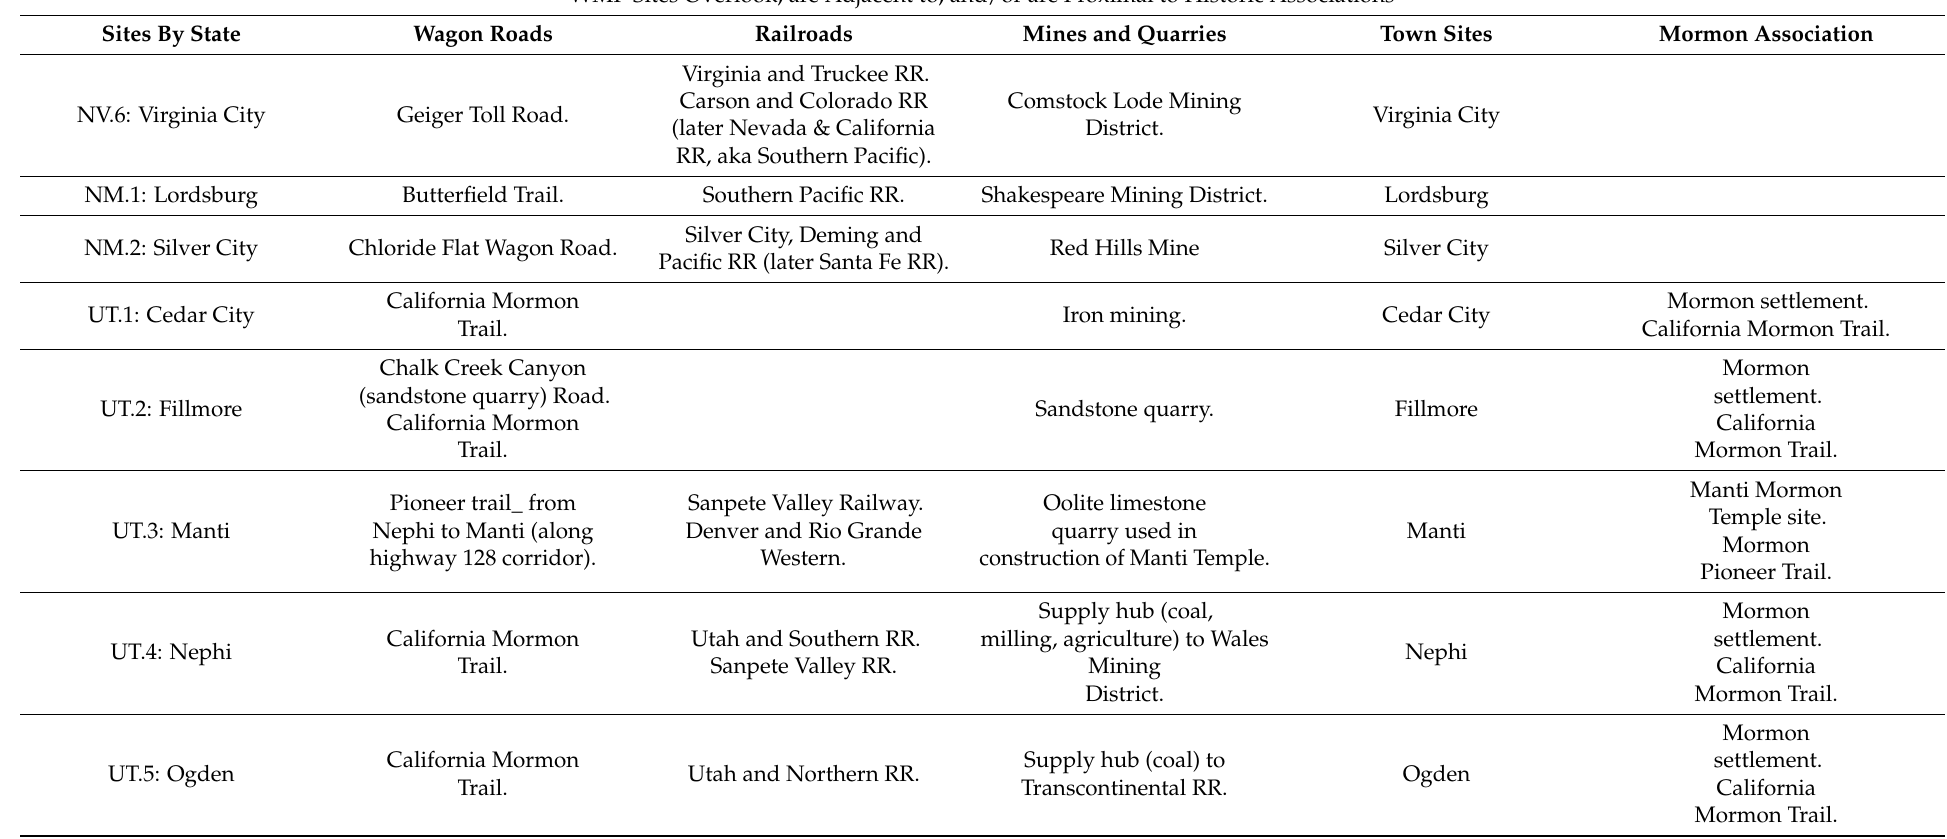
Table A2. Cont. WMP Sites Overlook, are Adjacent to, and/or are Proximal to Historic